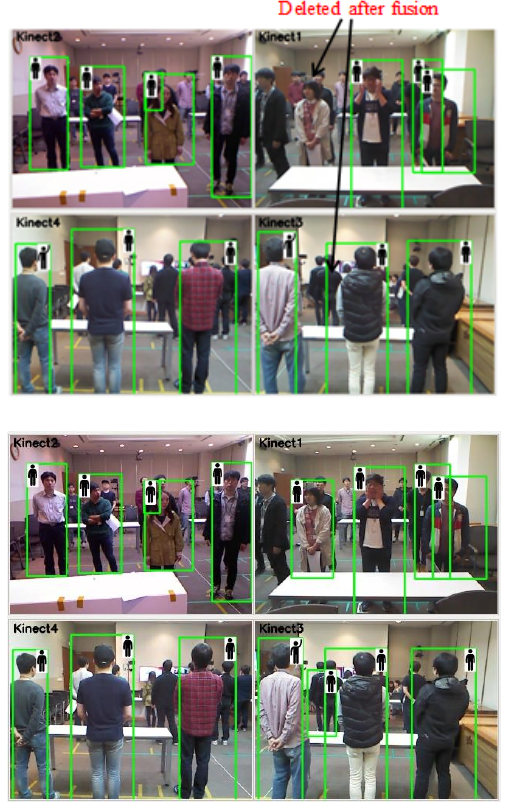
Fig. 9: Comparison between proposed method with method [14]. (a) Result of [14], (b) result of proposed